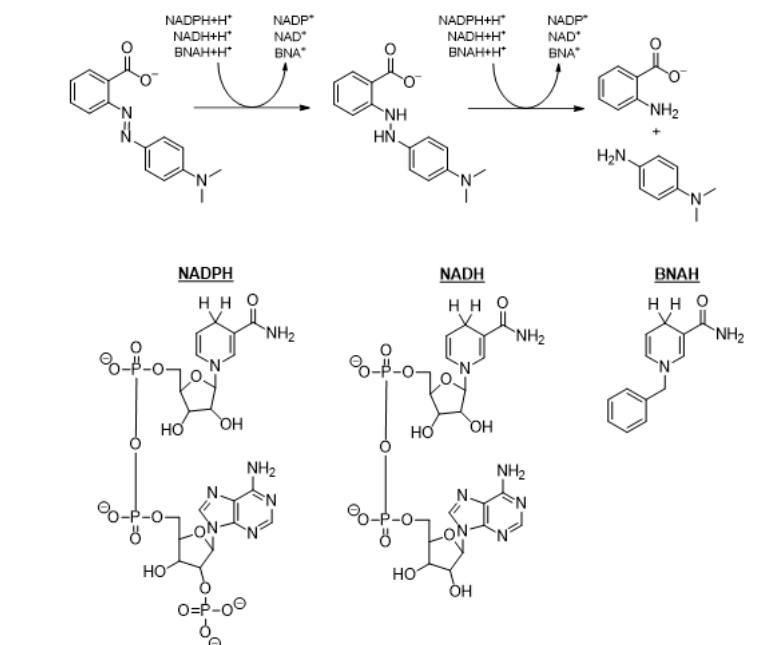
Figure 4. ( A ) Reduction of the model azo dye substrate, Methyl Red, by an arbitrary azoreductase. Most azoreductases use NADPH or NADH as an electron donor to proceed with the